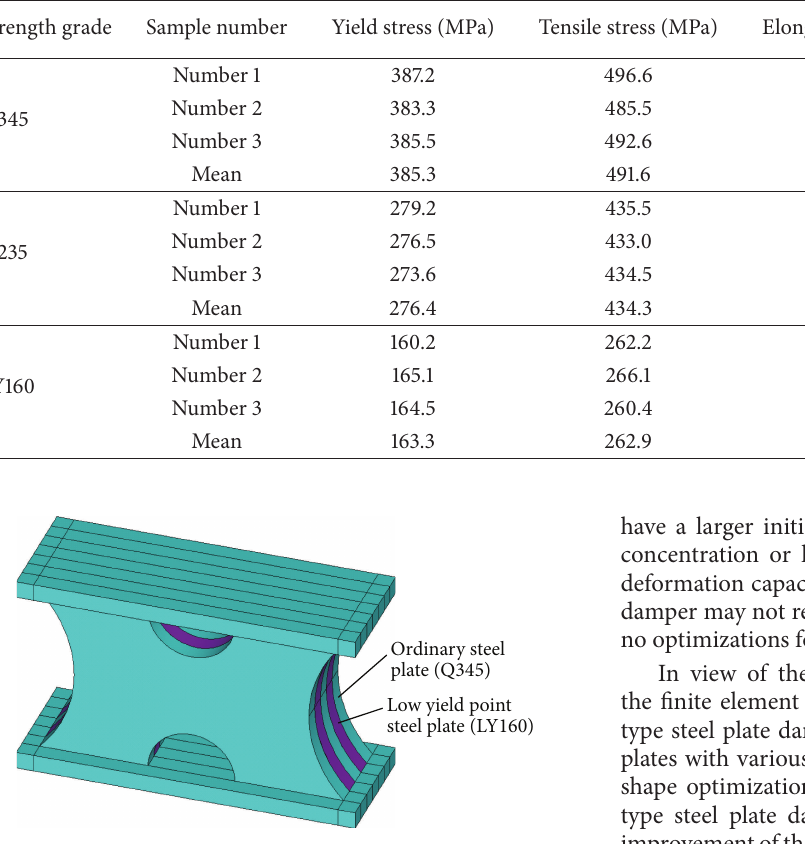
Figure 5: Composition of combined low yield point steel plate